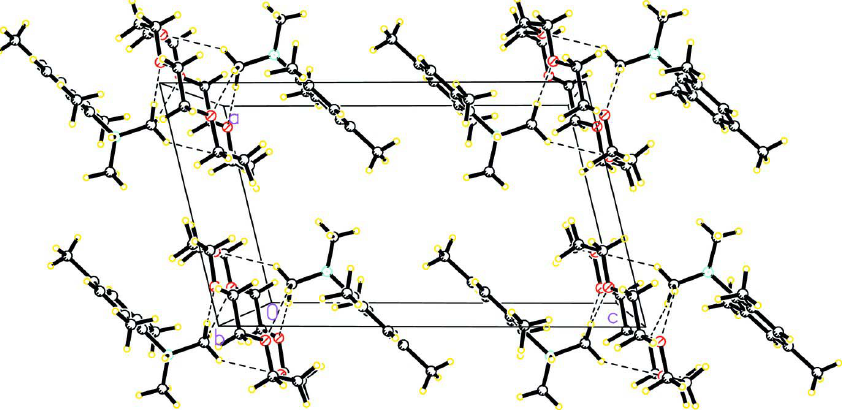
Figure 1 Perspective view of the title compound, showing the displacement ellipsoids drawn at the 30% probability level. Atoms with the suffix A are generated by symmetry code -x, 2-y, 1-z.